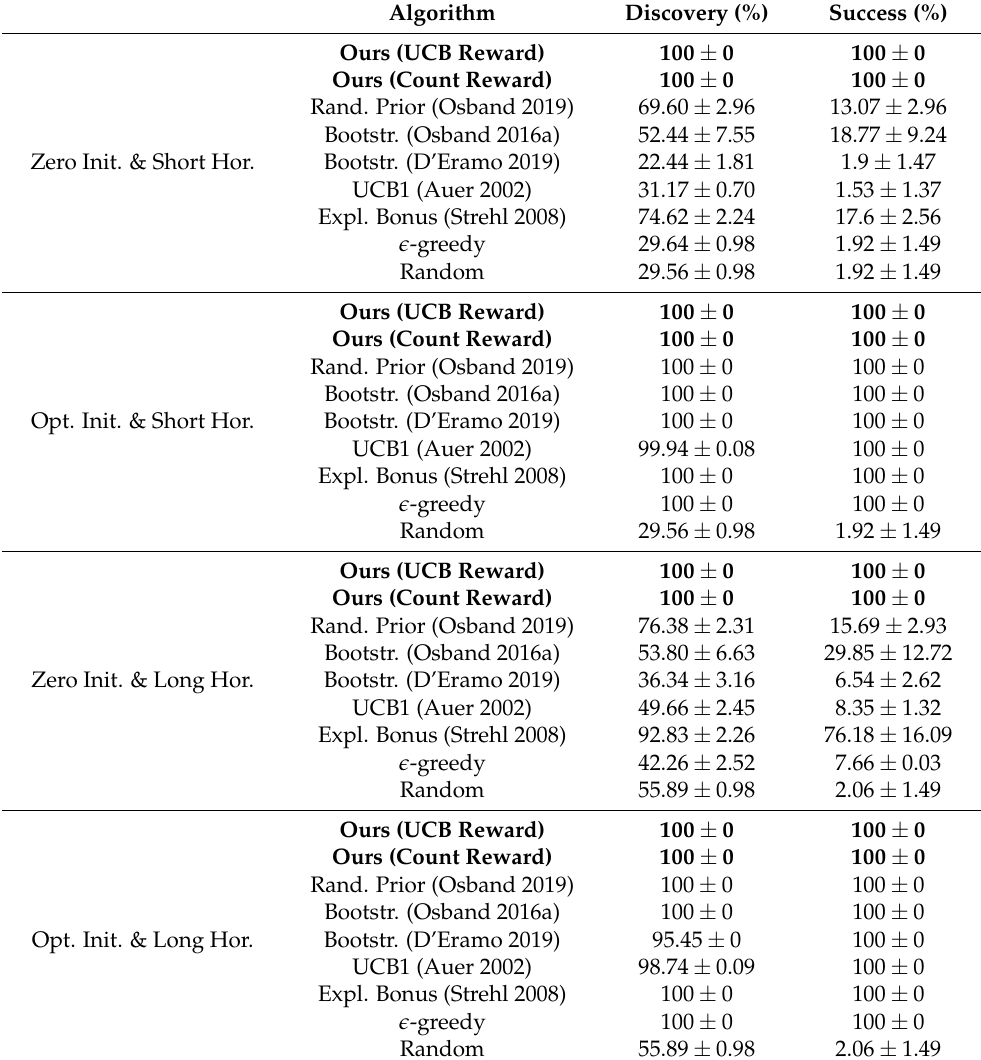
Table A3. Taxi results recap.